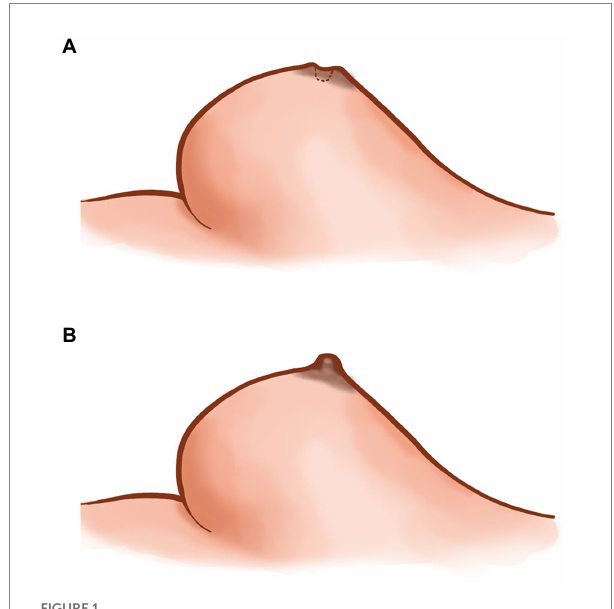
FIGURE 1 The plan of sunken nipple (A) , and plan of sunken eversion (B)